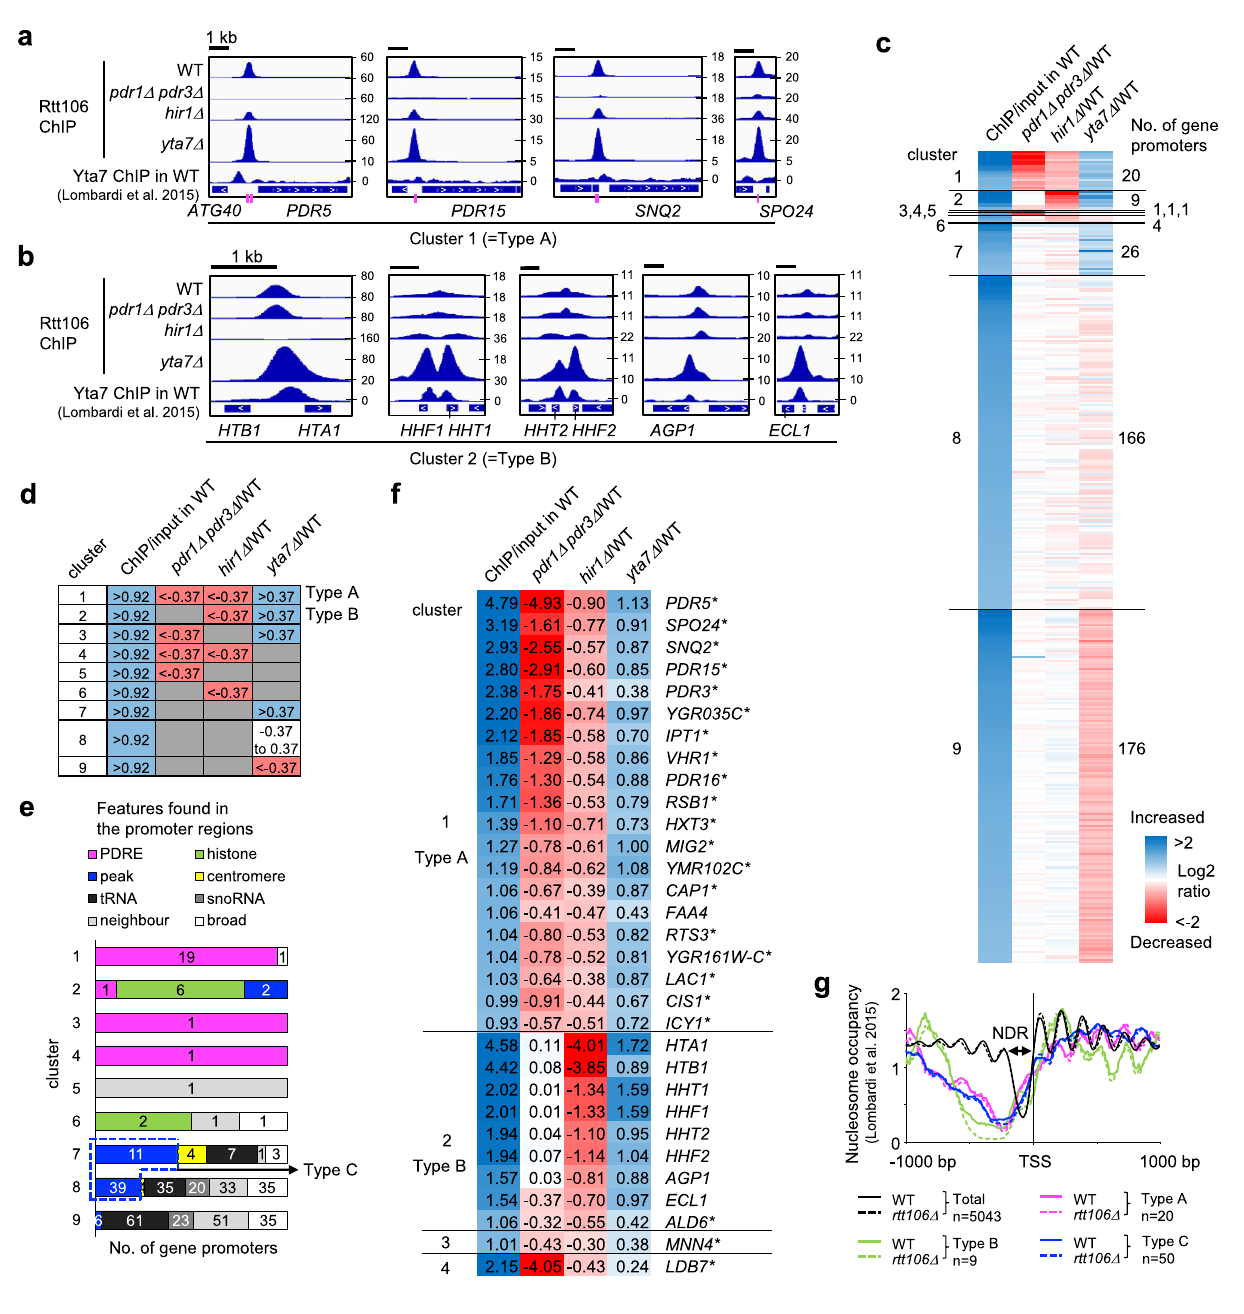
Fig. 2 A series of ChIP-seq tests reveal three distinct modes of Rtt106 binding to promoters by clustering analysis. a Specimen views of promoters where Rtt106 binding is dependent on Pdr1/3 and Hir1 and limited by Yta7 (falling into cluster 1, designated as Type A). Yta7 binding tested by ChIP-seq analysis 29 is shown alongside Rtt106 binding. Positions of PDRE indicated by magenta lines. b Specimen views of promoters where Rtt106 binding is independent of Pdr1/3, dependent on Hir1 and limited by Yta7 (falling into cluster 2, designated as Type B). ChIP-seq analyses of Rtt106 in WT, pdr1 Δ pdr3 Δ , hir1 Δ and yta7 Δ mutants are shown. c Clustering analysis of Rtt106 promoter association based on Rtt106 binding in WT and its changes in pdr1 Δ pdr3 Δ , hir1 Δ and yta7 Δ . Log2 fold enrichment of Rtt106 binding in WT at promoters (ChIP/input in WT) and log2 fold changes of Rtt106 binding in pdr1 Δ pdr3 Δ , hir1 Δ and yta7 Δ compared to that in WT ( pdr1 Δ pdr3 Δ /WT, hir1 Δ /WT and yta7 Δ /WT, respectively) were calculated as described in Methods. d Criteria used for clustering in panel c . e Features found in promoters categorised into clusters 1 – 9. Numbers of gene promoters containing PDRE (PDR responsive element; magenta), centromere (yellow), tRNA (black) or snoRNA (dark grey), and those containing Rtt106 signals leaked from highly expressing neighbour genes ( ‘ neighbour ’ ; light grey) are shown. Histone gene promoters ( ‘ histone ’ ; green) were assessed separately. Other than the above features, numbers of promoters with Rtt106 peaks ( ‘ peak ’ ; blue) or broad signals ( ‘ broad ’ ; white) are shown. Promoters with ‘ peaks ’ in clusters 7 and 8 designated as Type C. f Gene promoters categorised into clusters 1 – 4. Log2 changes are shown as in c . Asterisks indicate gene promoters containing PDRE. g Nucleosome occupancy analysed by MNase-seq in WT and rtt106 Δ (Lombardi et al. 2015 29 ) aligned to transcription start site (TSS). Nucleosome- depleted region (NDR) in average of all gene promoters is